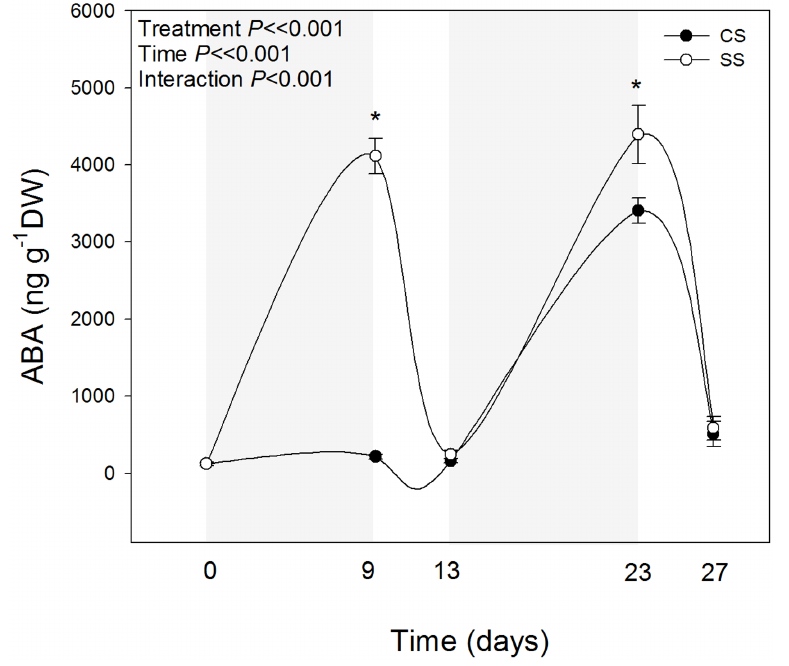
Fig 4. Endogenous concentrations of abscisic acid (ABA) in leaves of A . cordifolia . Data represent the mean ± SE of n = 7 individuals. Significant differences between groups were tested by two-way analysis of variance (ANOVA) and Duncan posthoc